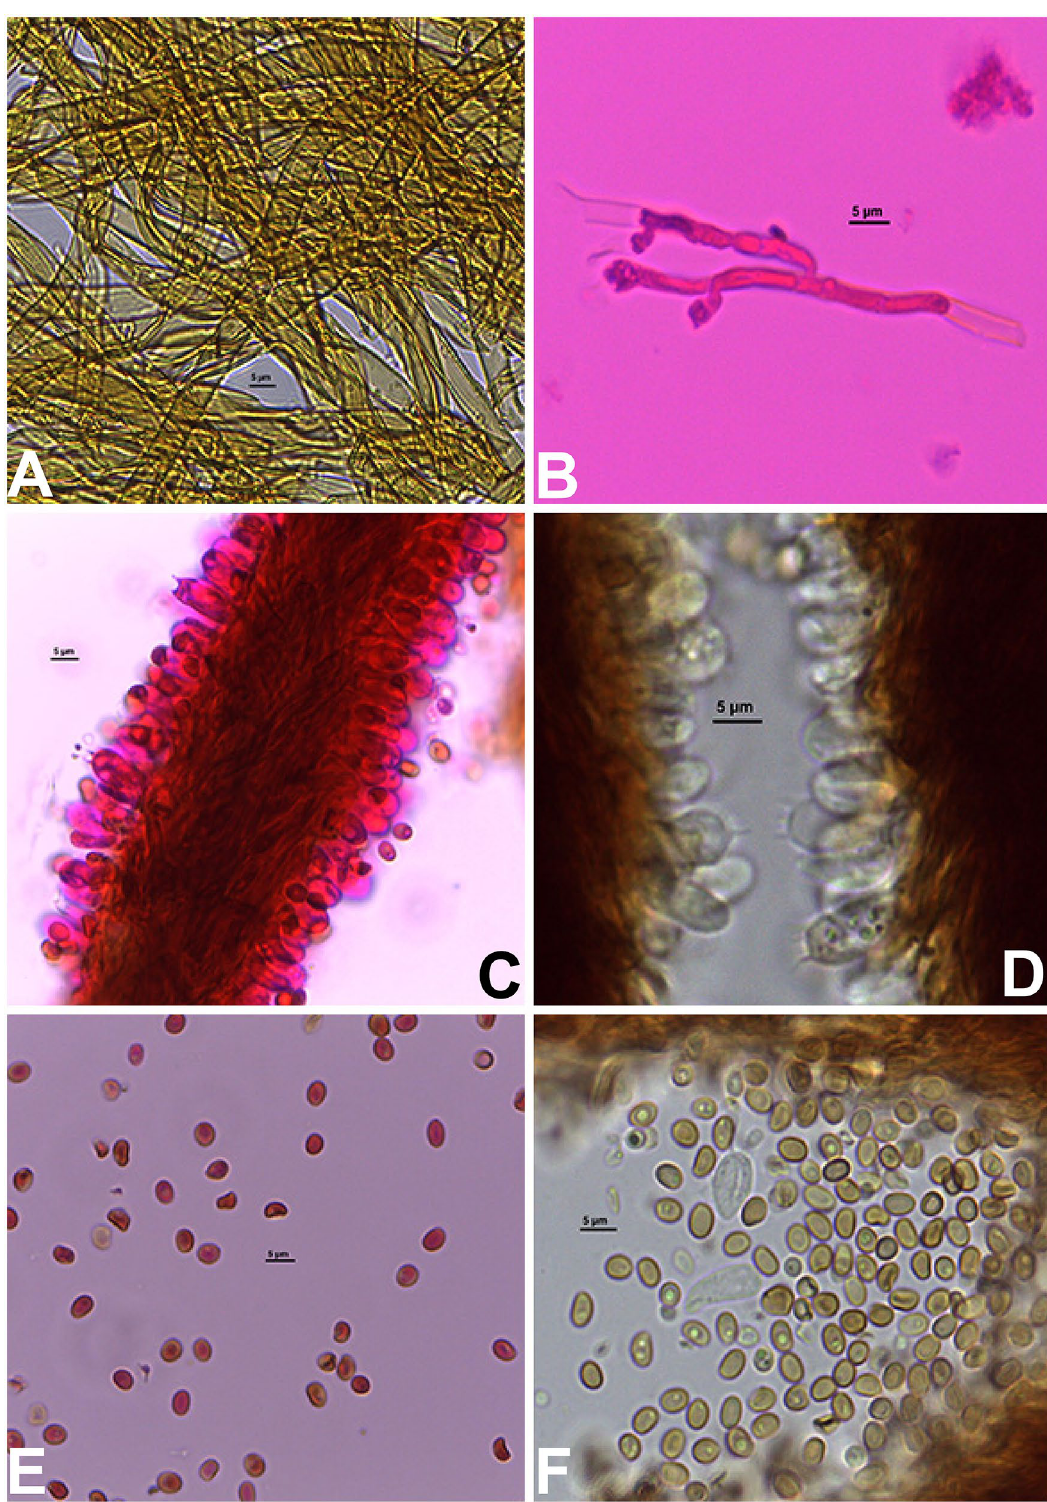
Figure 6. Microstructures of the type specimen of Phylloporia beninensis . ( A ) Hyphae from tomentum, ( B ) generative hyphae from trama in KOH mixed with 1% phloxine, ( C ) Section through the hymenium in KOH mixed with 1% phloxine showing basidia, basidioles, and basidospores, ( D ) section through the hymenium in KOH showing hyaline basidia and basidioles, some with several guttulae, ( E ) Basidiospores in KOH mixed with 1% phloxine, ( F ) Basidospores with one or two guttulae in